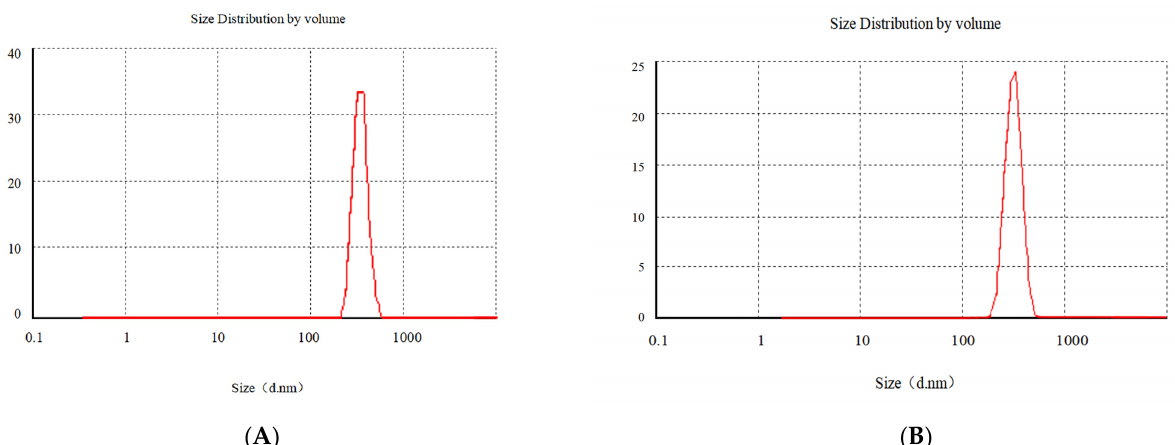
Figure 8. The particle size of Gen ‐ NH 2 ‐ MCM ‐ 41 ( A ) and Gen ‐ NH 2 ‐ MCM ‐ 41@SA nanoparticles ( B ).